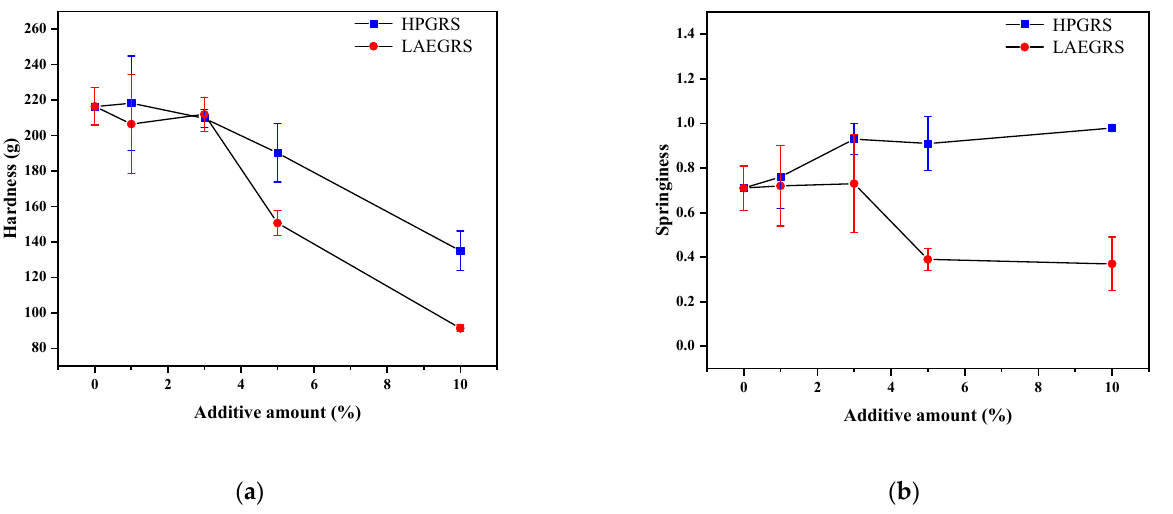
Figure 3. Hardness ( a ) and springiness ( b ) of different proportions of HPGRS and LAEGRS (0%, 1%, 3%, 5%, and 10%) blended with WS respectively.